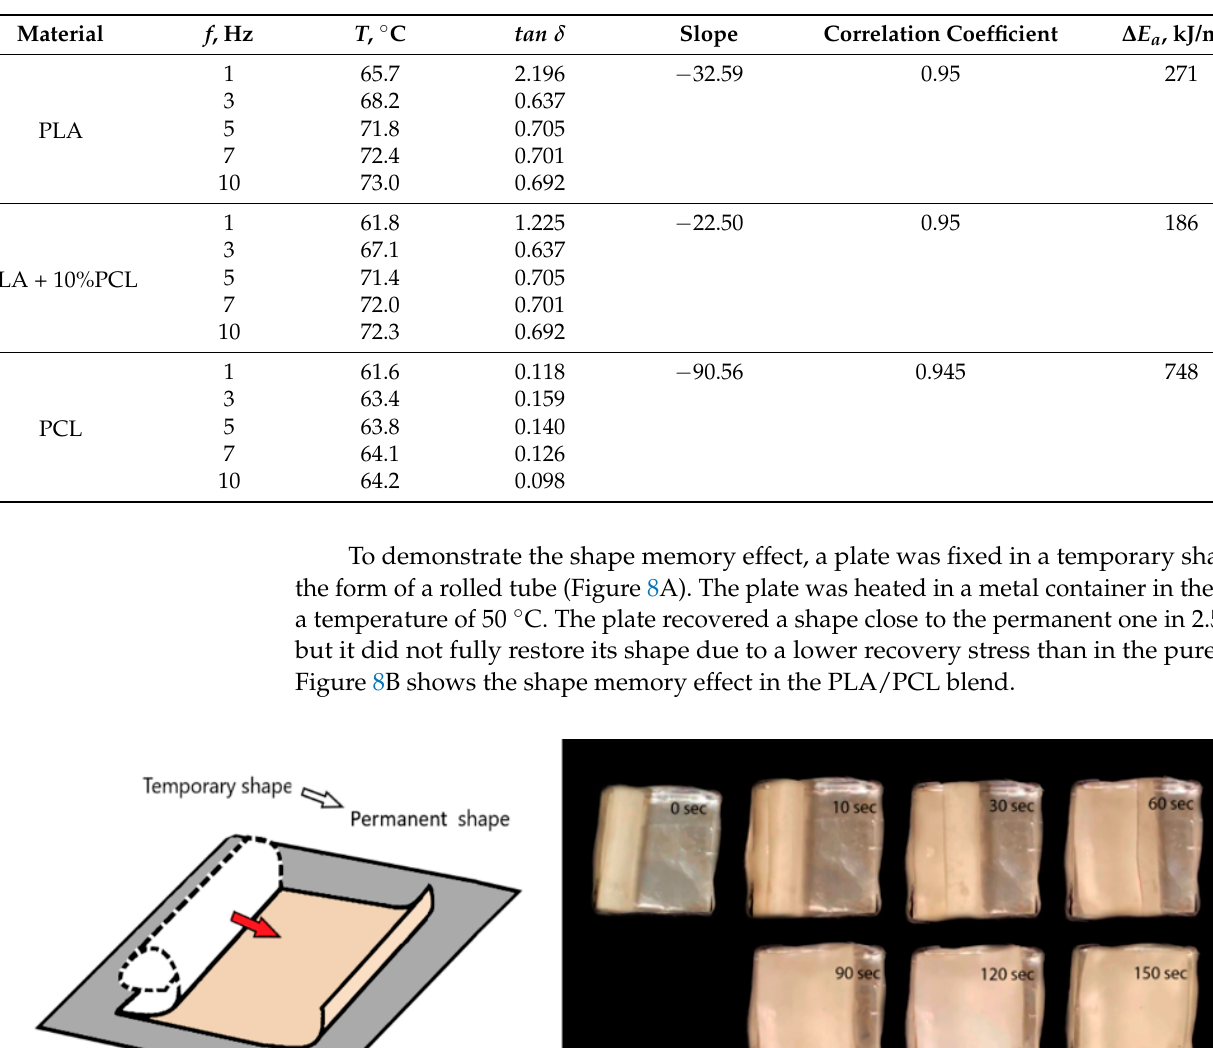
Table 2. Determination of the apparent activation energy ( E a ) of glass transition by DMA for the PLA, PLA + 10%PCL, and PCL samples.